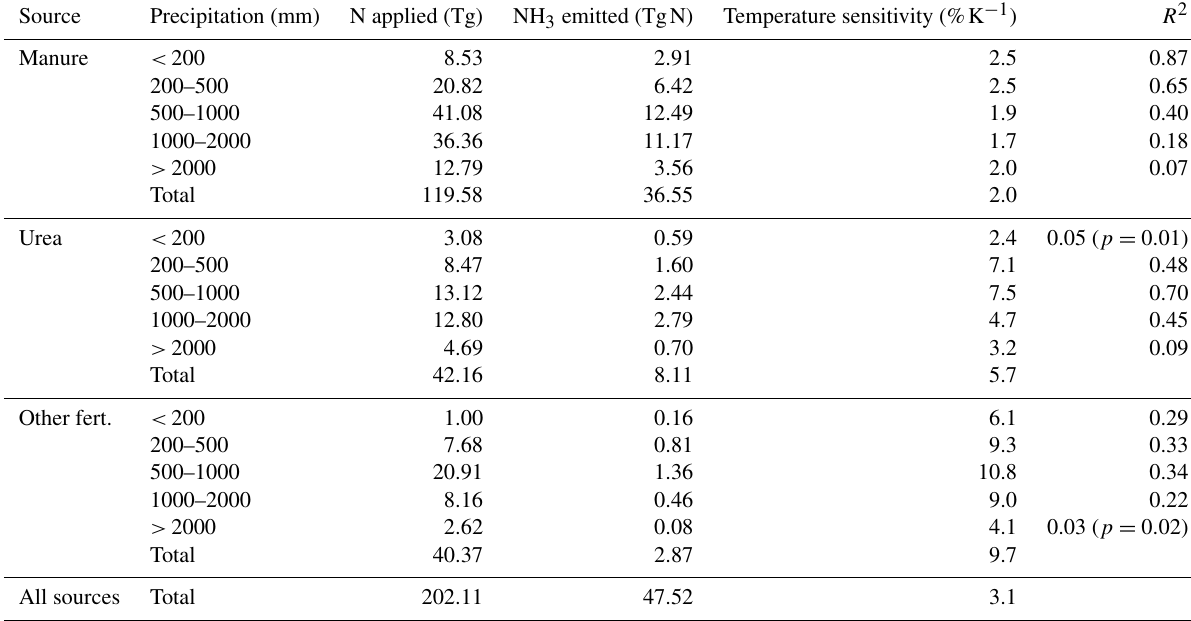
Table 3. Temperature sensitivity of NH 3 emissions from fertilizers and manure as estimated by linear regression for regions with varying annual precipitation. The coefficient of determination ( R 2 ) is shown for the linear fits for each precipitation class. The linear fits are statis- tically significant at p < 0 . 001 except where noted otherwise. The regression slope and intercept parameters are given in Table S3 in the Supplement. The sensitivities for total emissions (with no R 2 given) are obtained as weighted means of the sensitivities in each subcategory (Sect. S6 in the